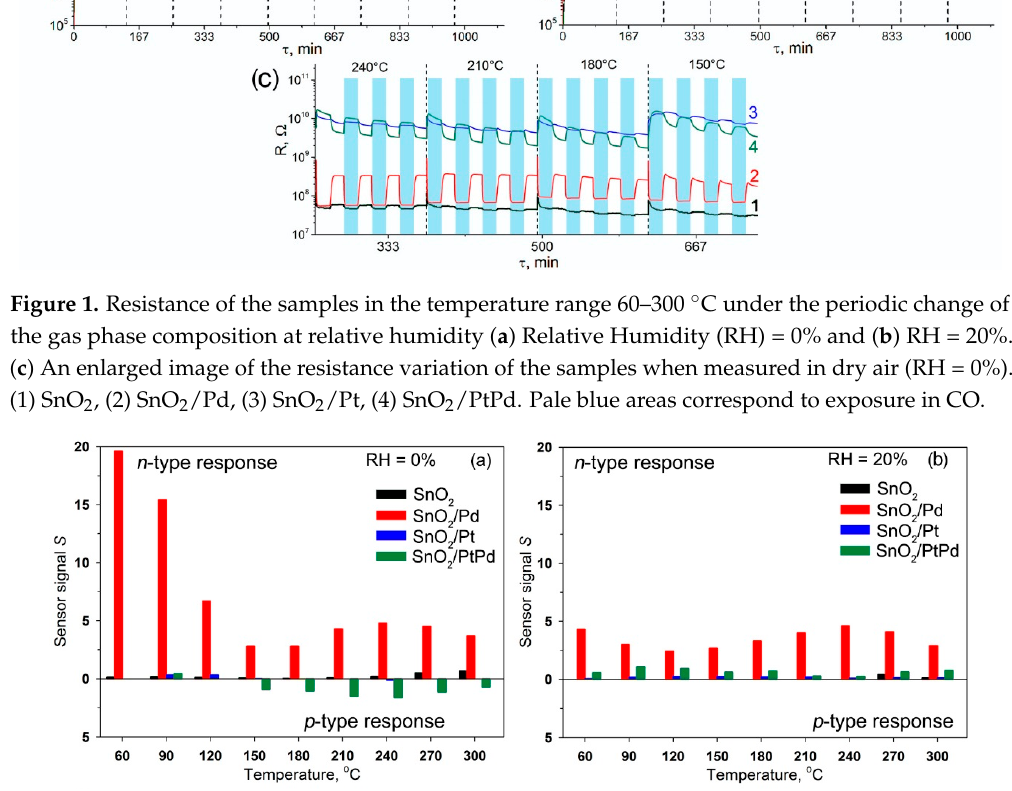
Figure 2. Sensor signal to 6.7 ppm CO of blank SnO 2 and mono- and bimetallic nanocomposites in the temperature range 60–300 °C at relative humidity RH = 0% ( a ) and RH = 20% ( b ).